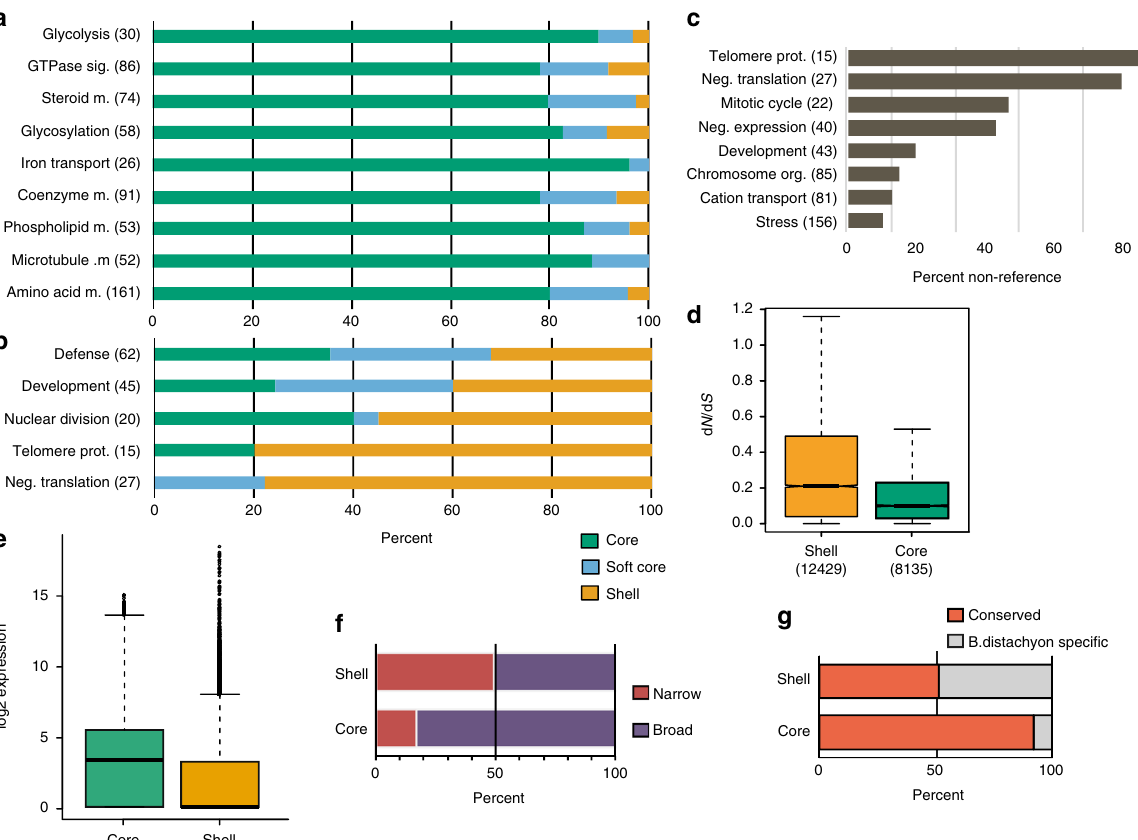
Fig. 3 Functional classi fi cation of pan-gene categories. Gene Ontology (GO) biological process categories enriched in the core a and shell b pan-gene subsets, showing the distribution of all genes in that category across the pan-genome. Note that the “ neg. (negative) translation ” category includes defensive peptides that inhibit translation. c Percent of respective GO biological process categories comprised of non-reference genes. Total number of genes in each category is listed after the category label on the y axis. d The ratio of non-synonymous to synonymous mutations indicates that shell genes are evolving faster than core genes within B. distachyon ( p < 2.2e − 16, t -test). e Core genes are expressed at higher levels than shell genes ( p < 2.2e-16, Wilcoxon signed rank). f Core genes are more broadly expressed within multiple tissues than shell genes and g are more likely to be identi fi ed as conserved in rice or sorghum. Whiskers in the above plots extend to the most extreme data point which is no more than 1.5 times the